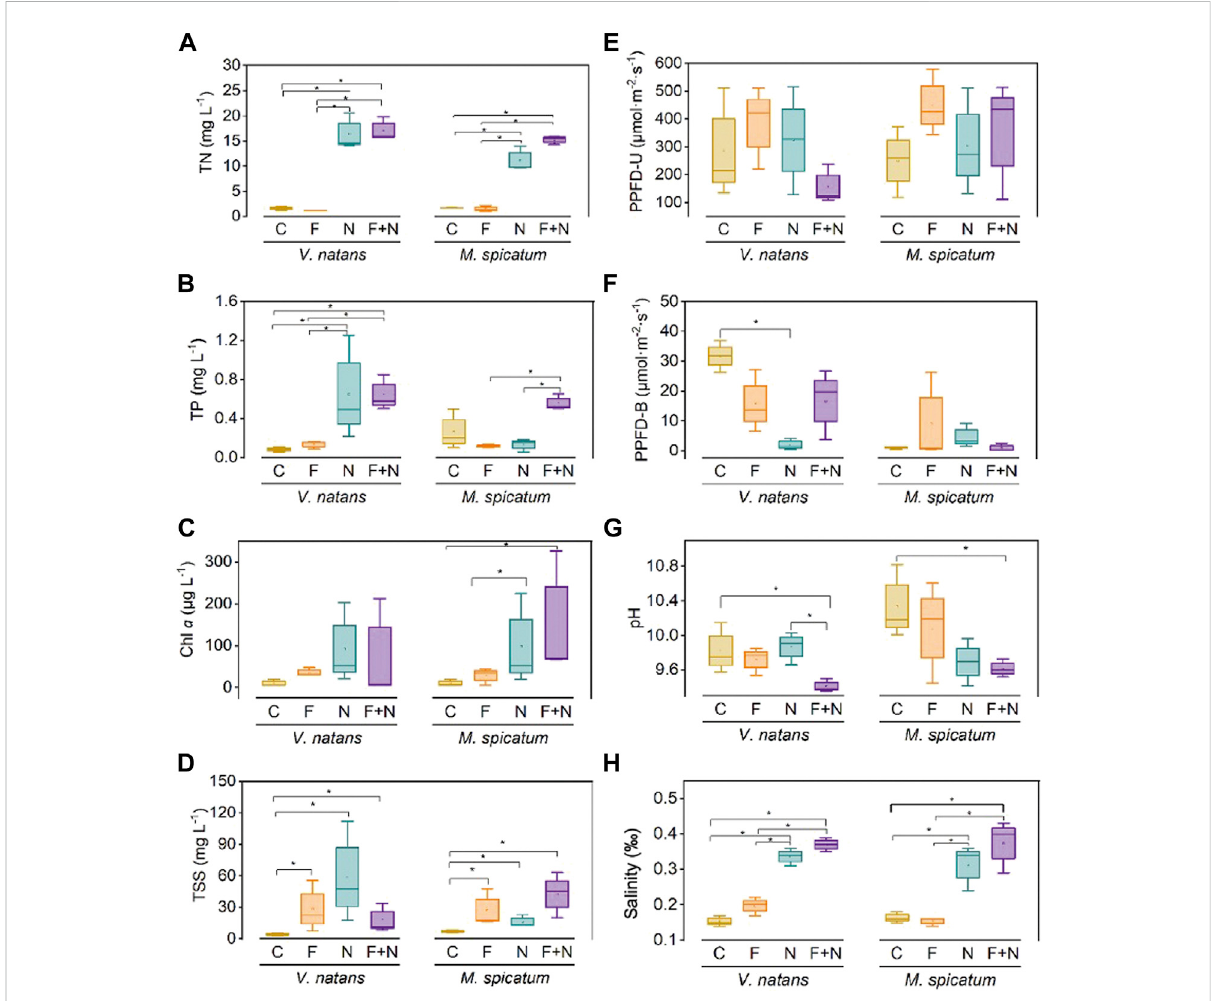
FIGURE 2 Physico-chemical water variables (mean ± SD) including total nitrogen (TN, mg L − 1 ) (A) , total phosphorus (mg L − 1 ) (B) , phytoplankton chlorophyll a (Chl a , μ g L − 1 ) (C) , total suspended solids (SS, mg L − 1 ) (D) , photosynthetic photon fl ux density in the upper layer of water